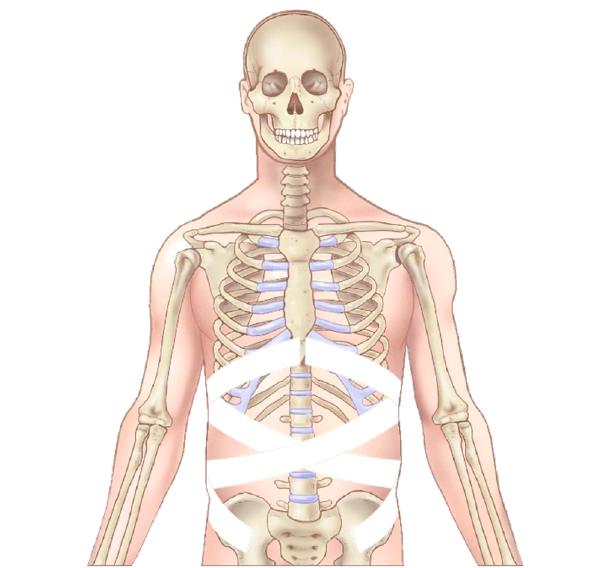
Figure 2. Manipulation of the kinetic chain by attaching four strokes of short-stretch (60%) tape in a circular manner at the skin around the lower part of the trunk of the participant from the pelvis to the trunk at the height of